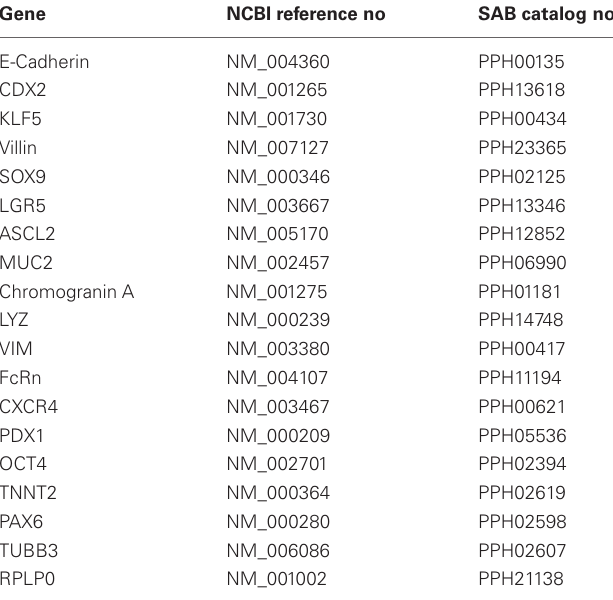
Table 2 | List of probes used in Custom RT 2 Profiler PCR array mRNA expression analyses of intestinal and control markers in intestinal epithelial